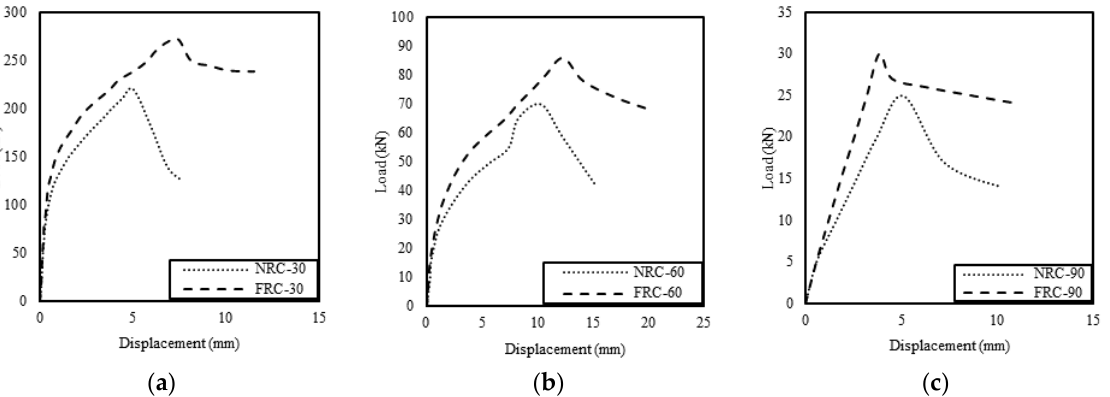
Figure 13. Load – horizontal displacement of V-shaped columns with ( a ) 30°, ( b ) 60°, and ( c ) 90° angles.